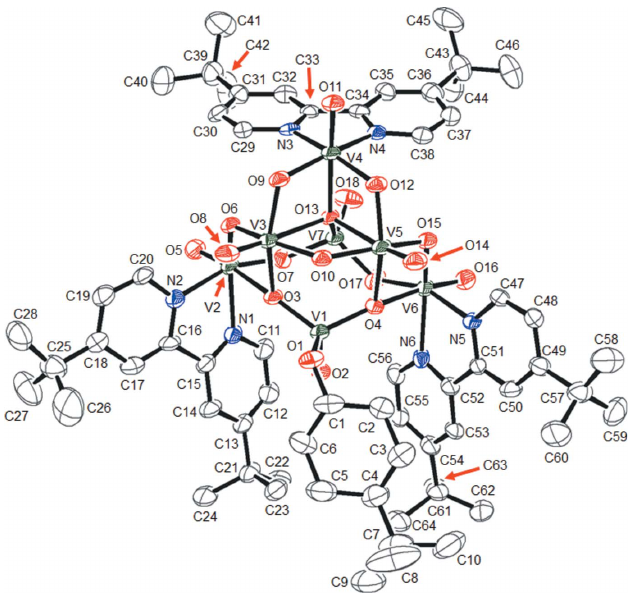
Figure 1 The molecular structure of the title compound, showing the atom- labelling scheme. Displacement ellipsoids are drawn at the 50% probability level. The solvent CH 3 CN molecule and H atoms have been omitted for